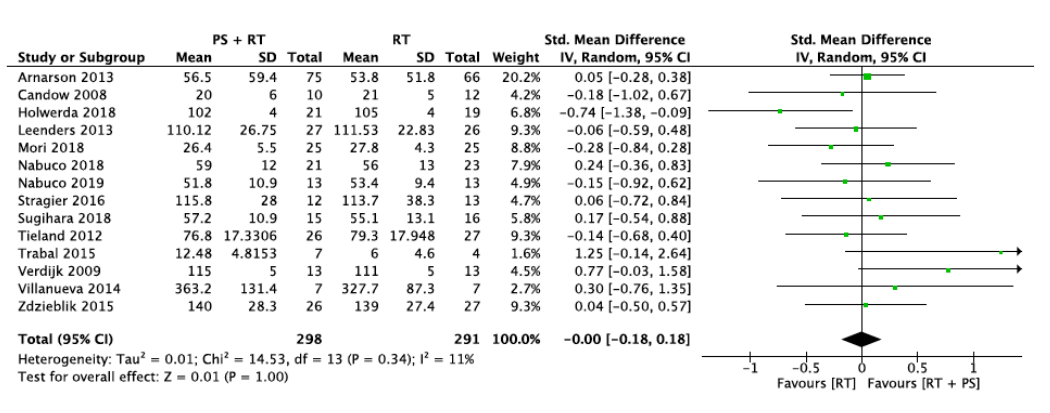
Figure 3. Risk of bias graph.